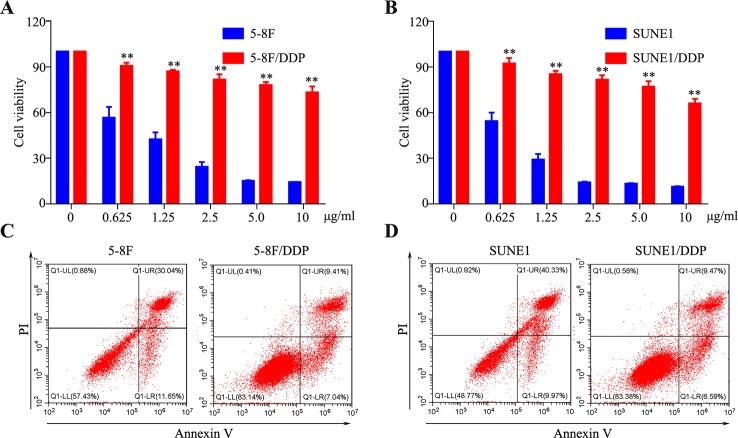
Establishment of cisplatin-resistant nasopharyngeal carcinoma (NPC) cells. (A, B) A CCK8 assay was conducted in parental and 5-8F/DDP (A) and SUNE1/DDP (B) cells. (C, D) Representative images of cell apoptosis in the 5-8F/DDP (C) and SUNE1/DDP (D) cells treated with DDP for 48 h, as determined using an Annexin-V/propidium iodide (PI) assay. All experiments were performed at least three times; data are mean ± SD. **P < 0.01 vs. control, Student's t-test.